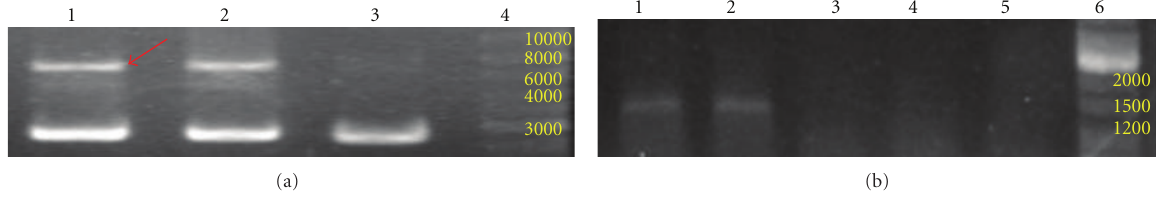
Figure 4: (a) Linearized pLEXSY-hyg2-FVII construct with SwaI (Lanes 1, 2), control plasmid (Lane 3). The arrow head shows a 6500-bp fragment containing cDNA sequence encoding human FVII, hygromycin B resistance gene, 5 (cid:3) and 3 (cid:3) portion of the small subunit of L. tarentolaer RNA gene (5 (cid:3) and 3 (cid:3) ssu) and three UTRs: utr1, utr2, and utr3. (b) Confirmation of FVII expression by transfected Leishmania cells Lanes (1, 2), Control cells (Lanes 3, 4), Control plasmid (Lane 5).